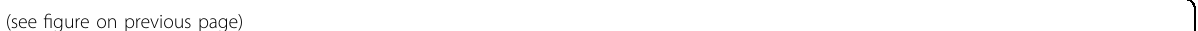
Fig. 1 SMYD2 expression is upregulated and its overexpression is associated with poor prognosis in patients with LUAD from the online database. A Box plots demonstrated SMYD2 mRNA upregulation in LUAD relative to normal lung tissues (data downloaded from Oncomine). Relative SMYD2 mRNA expression in Okayama ’ s microarray datasets, which include 226 cases of LUAD and 20 normal lung tissues. Relative SMYD2 mRNA expression in Hou ’ s microarray datasets, which consist of 45 cases of LUAD and 65 normal lung tissues. B High SMYD2 expression levels were associated with a poorer prognosis of DFS and OS via GEPIA. C There was a worse prognosis in patients with overexpression SMYD2 in the LUAD cohort (GSE31210, n = 204). OS overall survival, DFS disease-free survival. D Frequency of mutation and genomic alterations in SMYD2 in LUAD was presented as a bar diagram. E The graph depicted the correlation between SMYD2 expression and copy number alterations in LUAD of TCGA data. Abbreviations represent the types of copy number alterations: deep deletions (DD), shallow deletion (SD), diploid (D), gain (G), and ampli fi cation (A) (* p < 0.05; ** p < 0.01; *** p < 0.001; **** p <